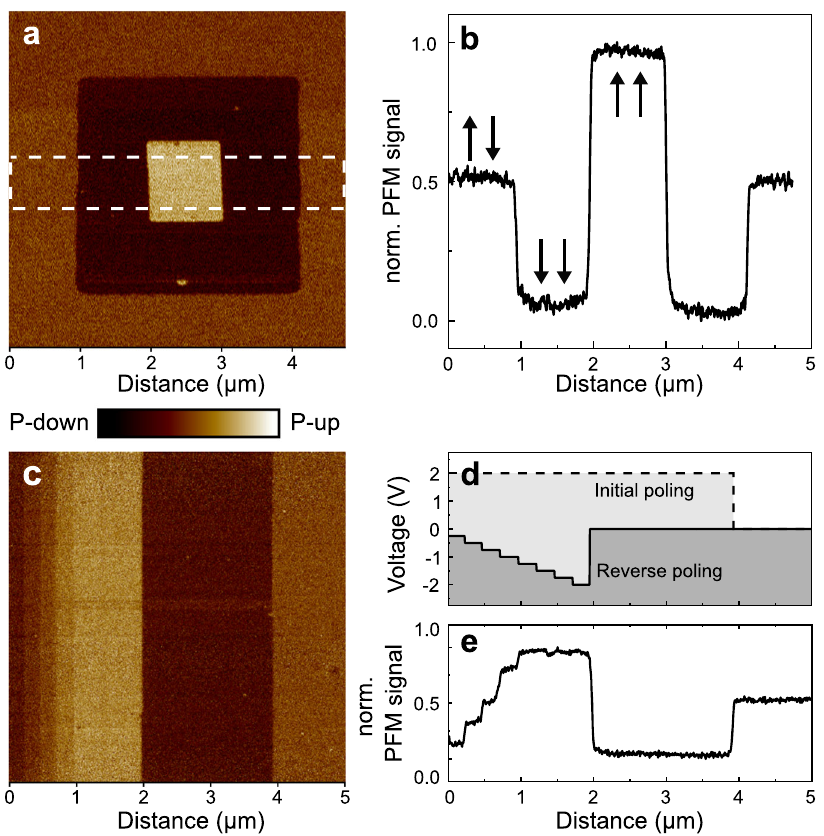
Fig. 2 Local switching characteristics of the PZT MPB thin fi lms. a The vPFM image after locally applying + 4 V (outer square) and − 2 V (inner square) between the scanning tip and the SRO bottom electrode. b Averaged vPFM signal across the dashed outline in ( a ). c The vPFM image after applying the incremental reverse poling scheme detailed in ( d ). d Poling voltage as function of the sample location for the two-step poling scheme applied on the image area in ( c ). e Averaged horizontal vPFM cross-section over the entire image in ( c